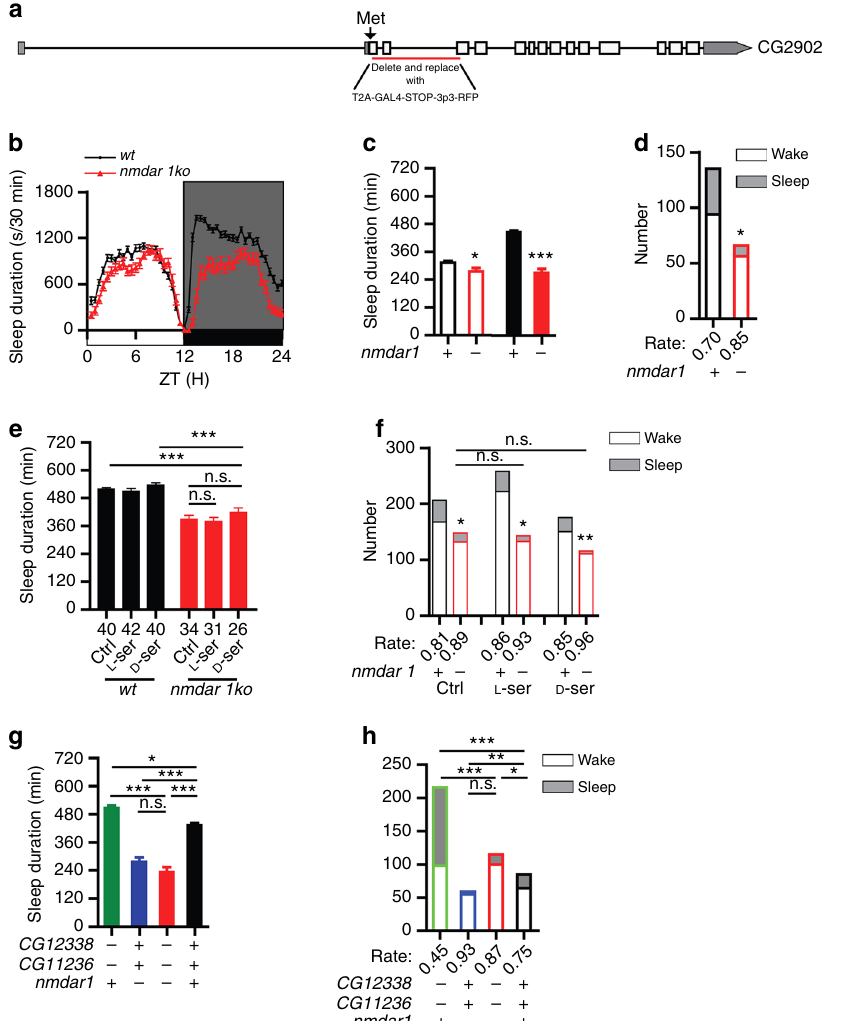
Fig. 4 Regulation of sleep by D-Ser upstream of the NMDAR1. a A schematic representation of nmdar1 gene. The single transcription variant (NM_169059) generates a protein of 997aa (NP_730940). The sequence from aa2 to 107 was deleted and replaced with T2A-Gal4-STOP-3P3-RFP in nmdar1ko fl ies. b Sleep pro fi les of nmdar1ko (red) ( n = 36) and wt (black) ( n = 69) fl ies, plotted in 30 min bins. c Statistical analyses. Daytime and nighttime sleep durations were signi fi cantly reduced in nmdar1ko fl ies. d Arousal rate of nmdar1ko fl ies (red) was signi fi cantly higher than that of wt (black). Numbers of fl ies that were aroused ( fi lled bars) and that kept sleep (open bars) were plotted for nmdar1ko and wt fl ies. e , f Neither L- nor D-Ser affected the sleep duration ( e ) or the arousal rate ( f ) of nmdar1ko fl ies. Numbers below each bar represent the number of fl ies tested in ( e ). g , h The sleep phenotype ( g ) and arousal phenotype ( h ) of daao-dko fl ies were masked by nmdar1ko in triple knockout fl ies. Nighttime sleep durations were signi fi cantly increased in daao-dko (green) ( n = 46) fl ies, and signi fi cantly decreased in nmdar1ko (blue) ( n = 32) and triple knockout (red) ( n = 34) fl ies, compared to wt (black) ( n = 47) fl ies ( g ). Arousal rate was signi fi cantly decreased in daao-dko (green) fl ies, and signi fi cantly increased in nmdar1ko (blue) and triple knockout (red) fl ies, compared to wt (black) fl ies ( h ). *** P < 0.001, ** P < 0.01, * P < 0.05, n.s. P > 0.05. Mann – Whitney test was used in ( c ), two-way ANOVA test with Bonferroni posttests was used in ( e ) to compare the sleep durations between wt and nmdar1ko under the same treatment, Kruskal – Wallis test with Dunn ’ s posttest was used in ( e ) for other statistical analyses and in ( g ). Fisher ’ s exact test was used in ( d ), ( f ), and ( h ). Error bars represent s.e.m. Male fl ies